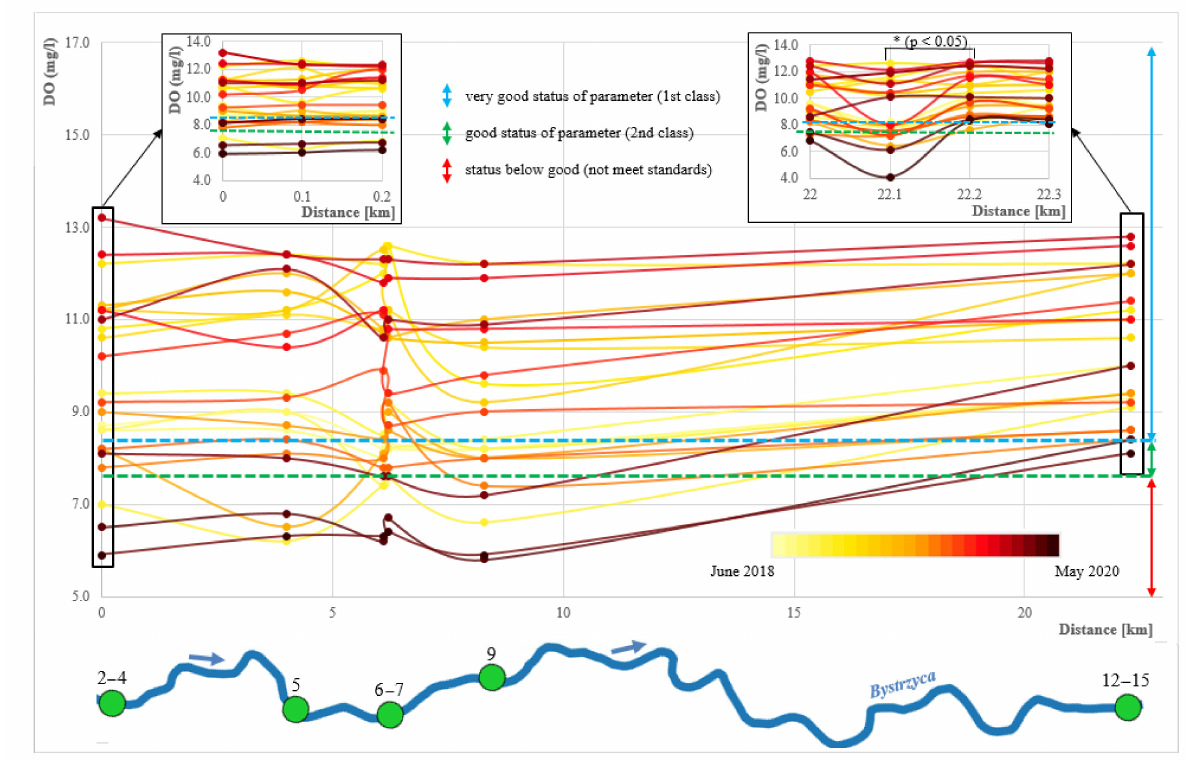
Figure A3. Temporal and spatial variability of DO at the tested measurement points, including the physicochemical condition of the parameter and statistical significance within the Sadowice, Skałka, and Marszowice HPs ( p < 0.05).